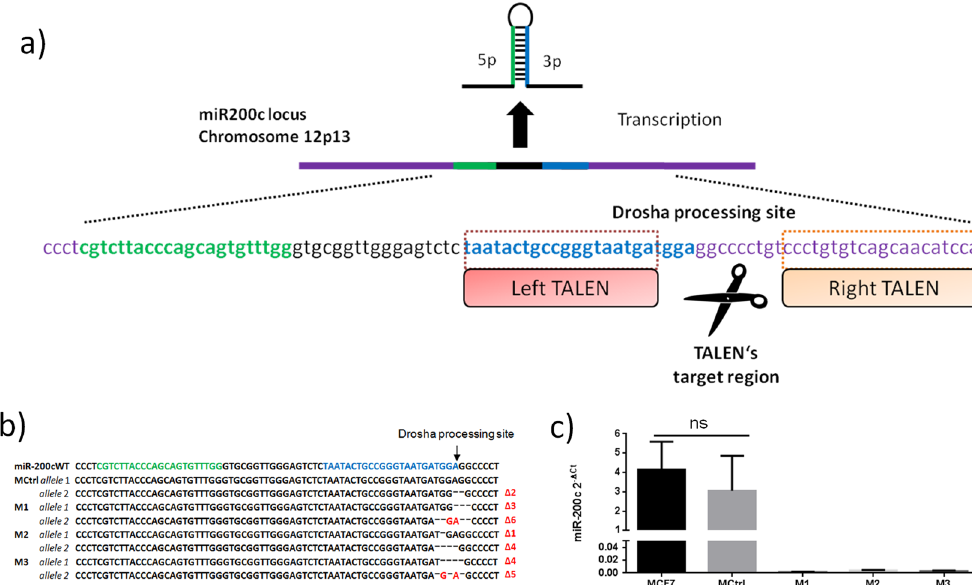
Figure 1. miR-200c genetic TALEN target sequences and knock-out confirmation. ( a ) The miR-200c gene is located at chromosome 12p13. TALENs were designed to target the miR-200c 3p drosha processing site. ( b ) Genomic DNA was extracted from MCtrl and M1, M2 and M3 clones, afterwards the miR-200c gene was amplified by PCR to perform sequencing of the miR-200c loci; MCtrl shows a heterozygous mutation while M1, M2 and M3 show various indels in the proximity of the miR-200c 3p drosha processing site on both alleles. ( c ) MCF7, MCtrl, M1, M2 and M3 miR-200c expression levels were analyzed by quantitative RT-PCR. Expression of miRNAs is shown as mean of three independent experiments ± SD. ns: no statistical difference, p > 0.05, one-way ANOVA post hoc